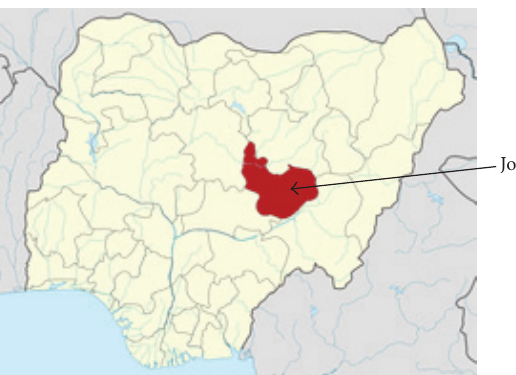
Figure 1: Map of Nigeria showing Plateau State (in red) and the City of Jos. https://upload.wikimedia.org/wikipedia/commons/thumb/ 6/66/Nigeria Plateau State map.png/250px-Nigeria Plateau State